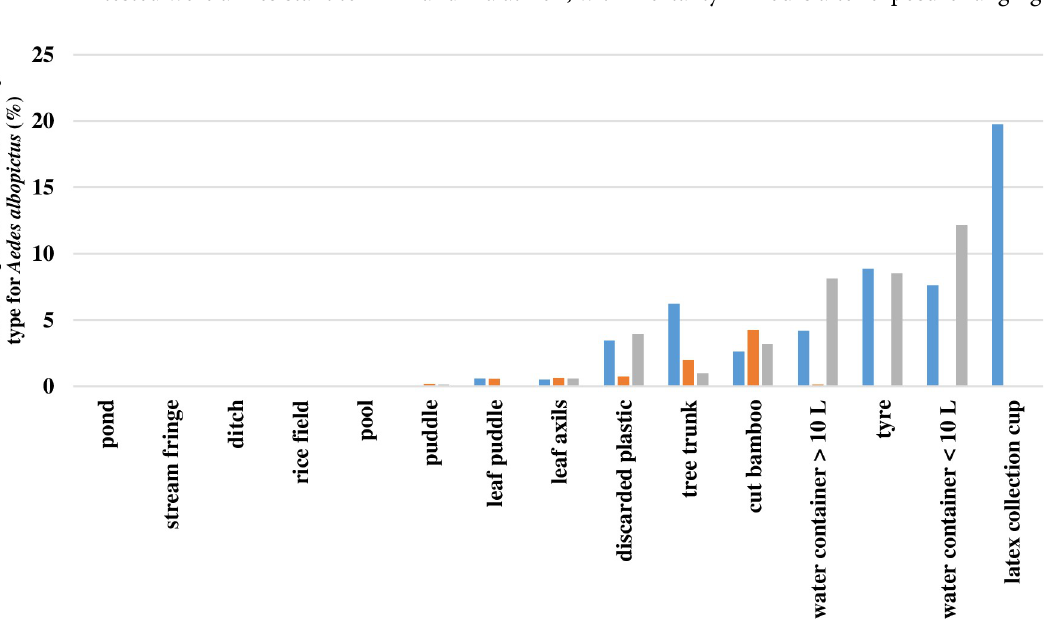
Fig 3. Aedes albopictus behaviour in the different habitats. The average number of female Aedes albopictus collected per person per hour in the secondary forests, mature plantations, immature plantations and villages during 24 h ( ▬●▬ rainy season (April to October), ▬■▬ dry season (November to March)).